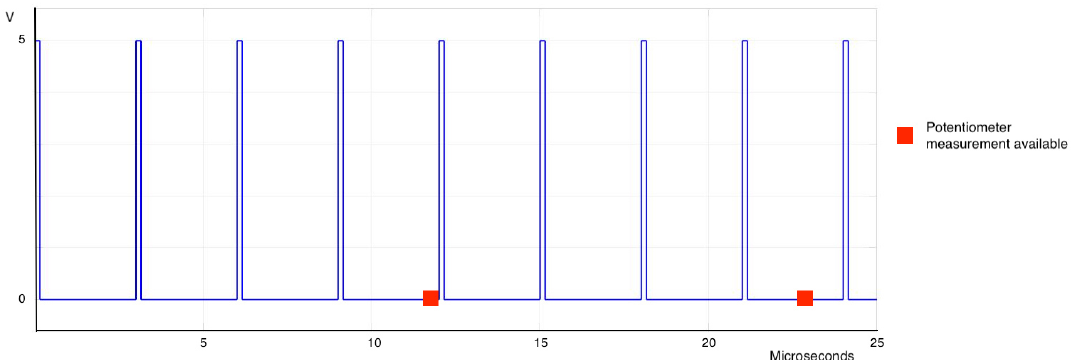
Figure 9. PFM signal with higher frequency than analog data acquisition. The red square shows whenever a new measurement from the potentiometer is available. That measurement will be the boundary for not losing information.